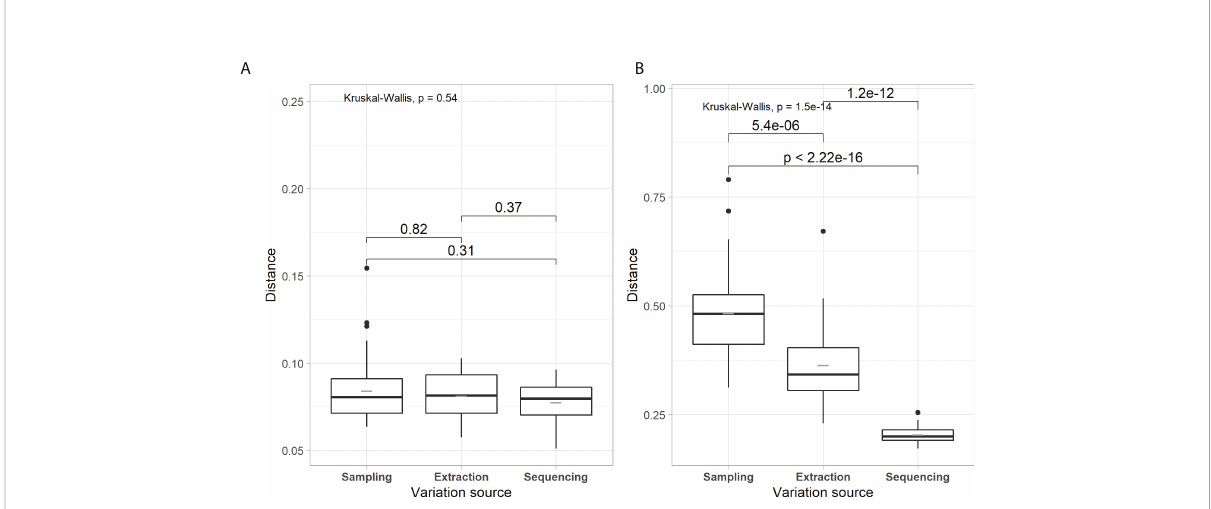
FIGURE 3 Box-and-whisker plots of weighted UniFrac distance for each component of the technical variability for prokaryotic (A) and fungal (B) communities. Boxplots are in the same format as those described in Figure 1. Kruskal-Wallis tests and post hoc pairwise Wilcoxon-test comparisons follow a similar format to Figure 1.